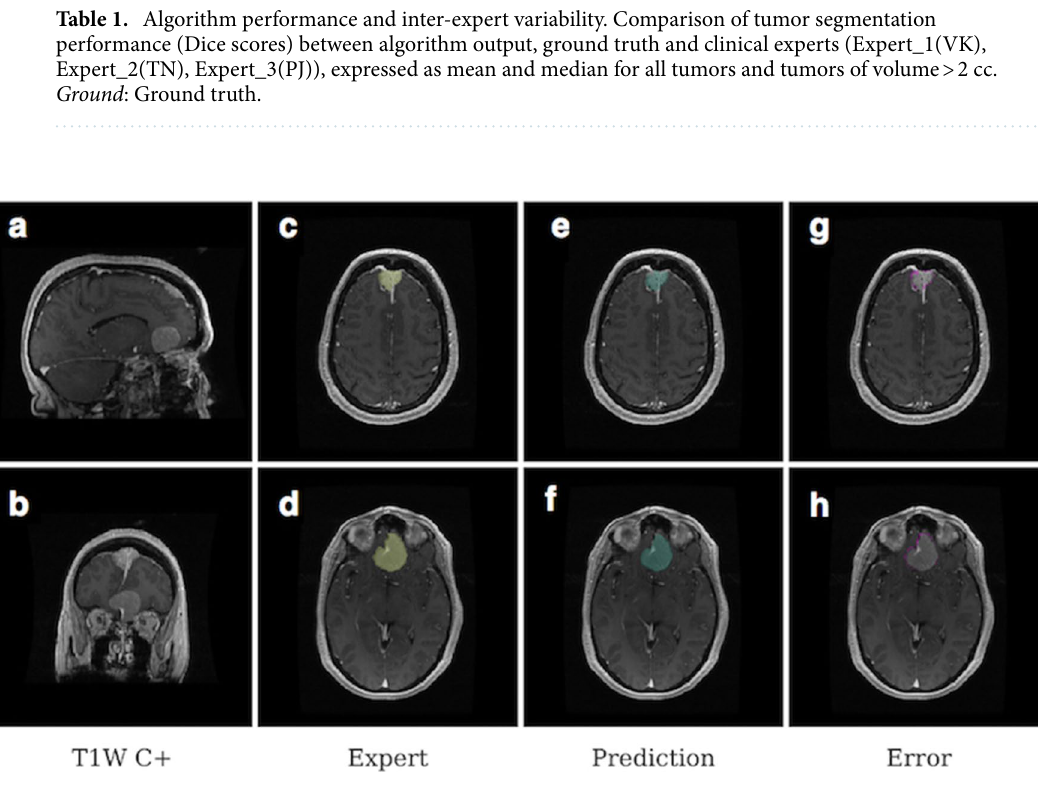
Figure 1. Example of meningioma segmentation algorithm output. Sagittal and coronal views ( a , b ) of a brain MRI scan containing two distinct meningiomas, one located in the convexity at the midline, the other located on the anterior skull base. Display of expert label vs computer-generated segmentation respectively of the meningioma of the convexity ( c and e ) and the meningioma of the skull base ( d , f ). Display of the mismatch between the expert label and the computer-generated segmentation on the meningioma of the convexity ( g ) and the meningioma of the skull base ( h